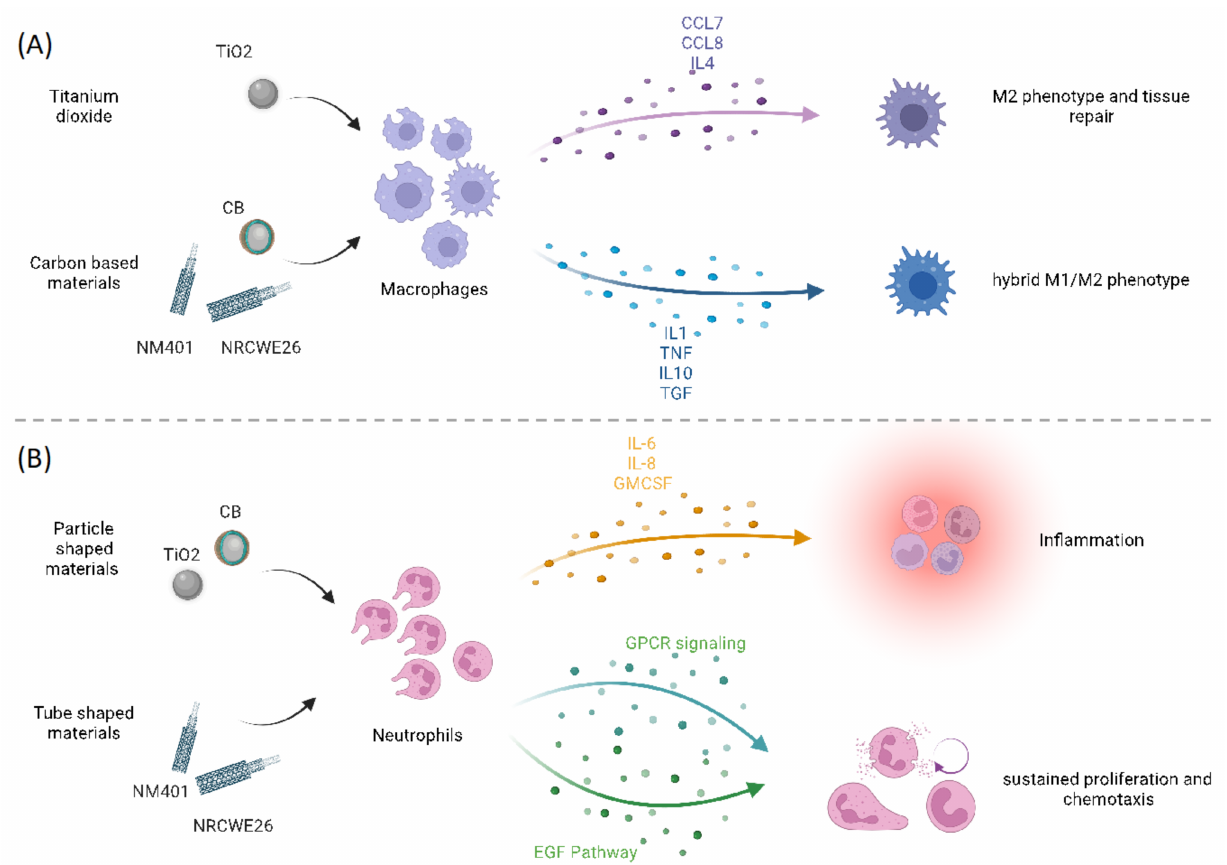
Figure 5. Graphic representation of the effect of ENM psychochemical properties on immune cell populations. In ( A ), the effect of different-shaped ENMs on neutrophils is reported by showing the different mediators and signaling pathways activated. In ( B ), ENMs with different chemistry are shown to differently polarize